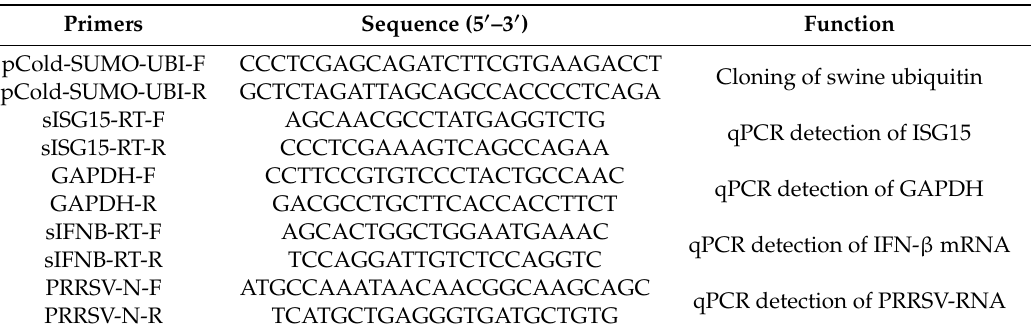
Table 1. Primers and corresponding